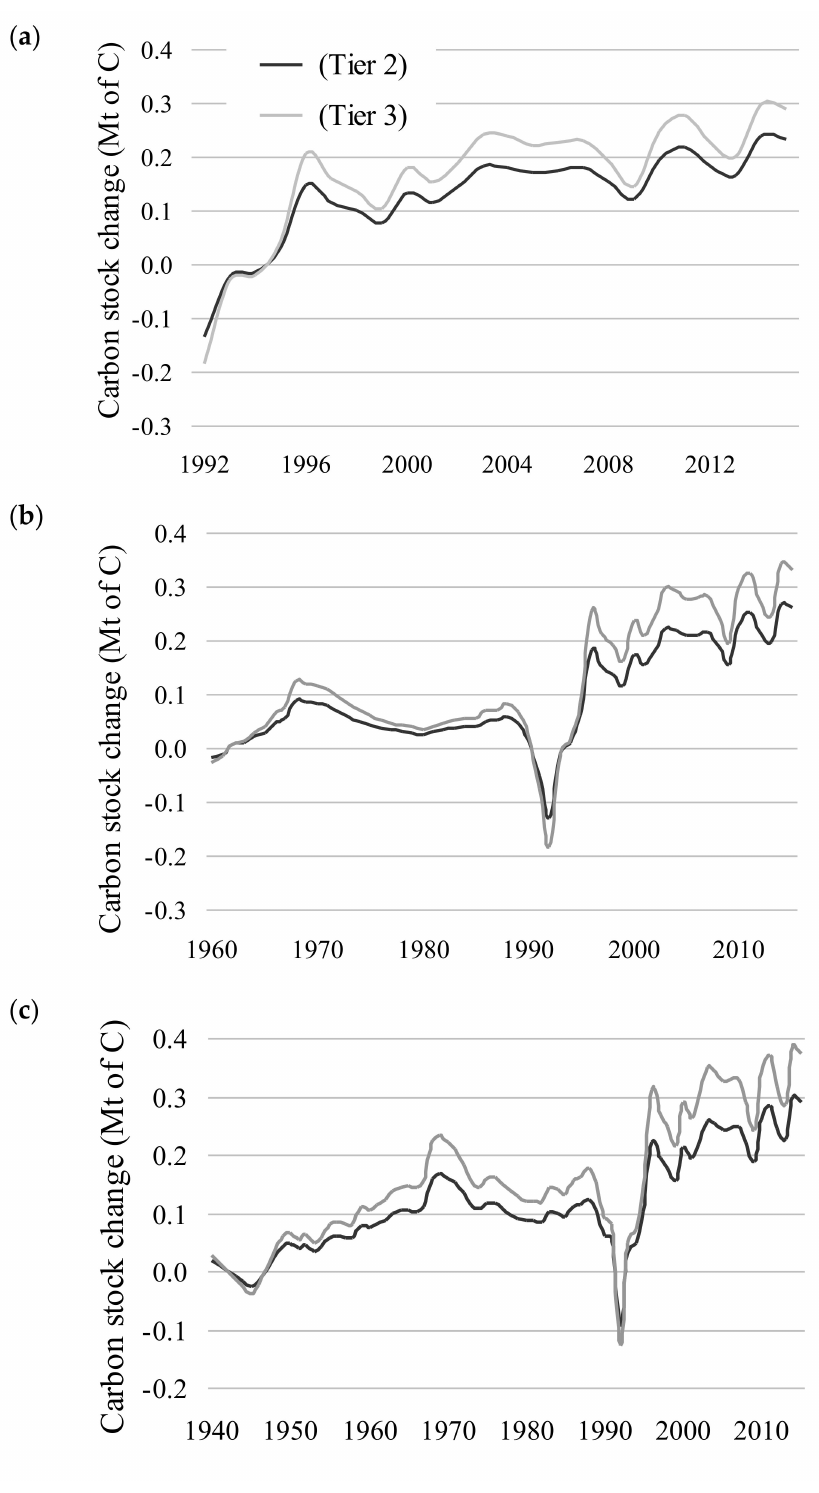
Figure 3. Historical carbon stock changes by applying the IPCC Tier 2 and Tier 3 methods. ( a ) estimates based on available FAO data (1992–2015); ( b ) estimates based on available literature data (1960–1991) and FAO data (1992–2015); ( c ) estimates based on data obtained from national statistics (1940–1991) and FAO data